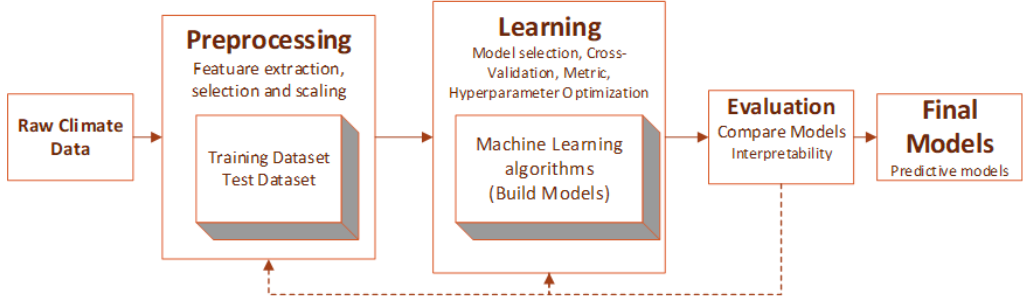
Figure 5. General flowchart of the proposed method.